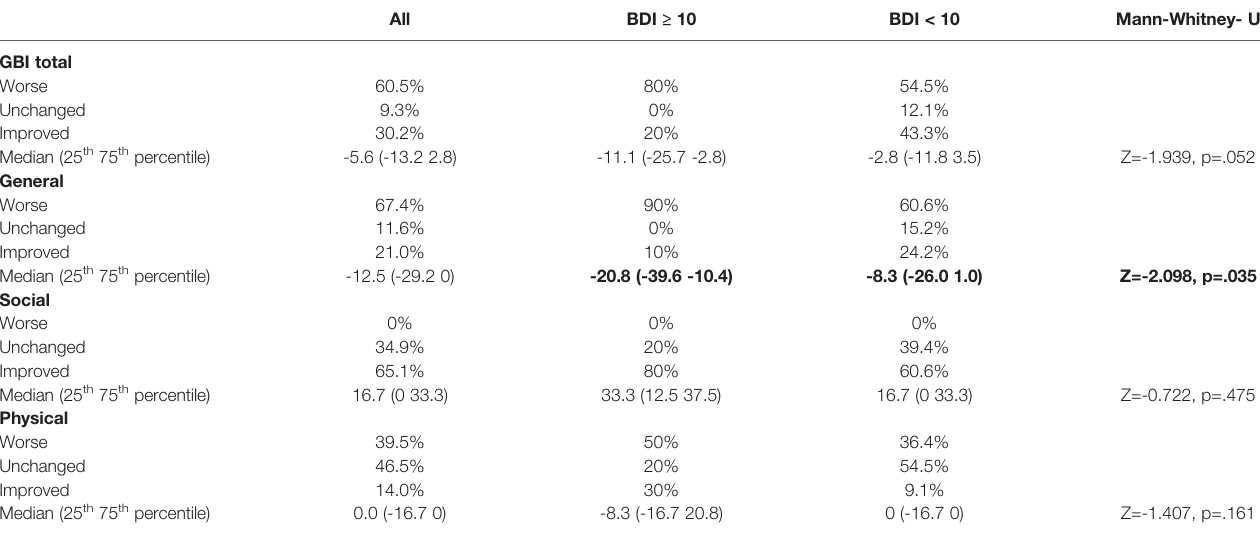
TABLE 4 | GBI with subgroup analysis, BDI ≥ 10 indicates